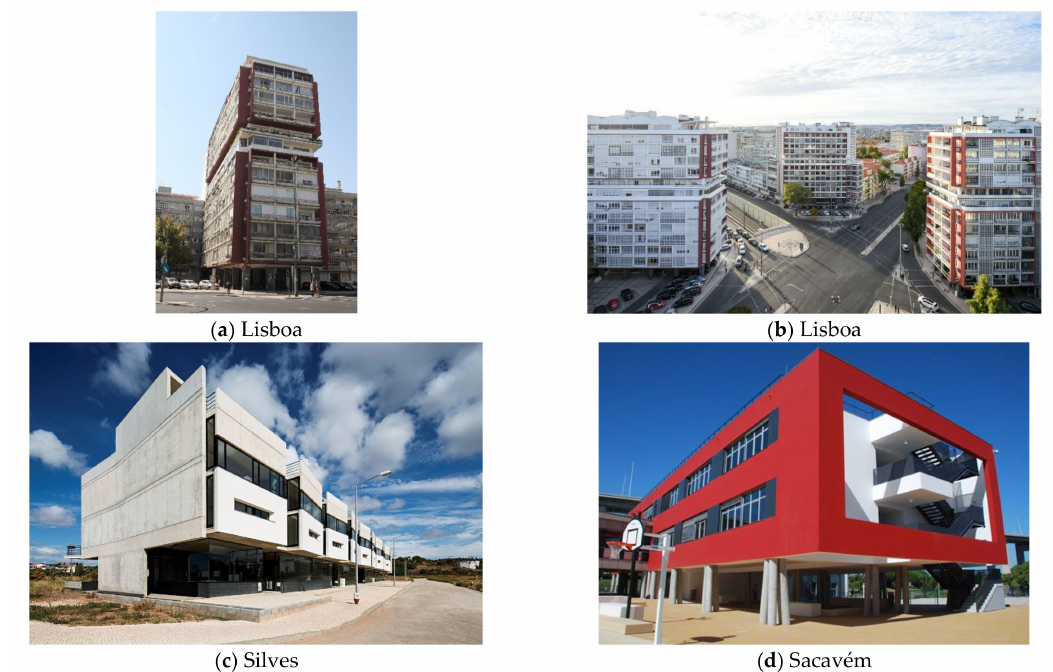
Figure 13. Examples of buildings with soft-storey configuration in Portugal: ( a ) 11-storey building; ( b ) general view of 11-storey structures with soft-storey configuration; ( c ) 4-storey building; and ( d ) school building.